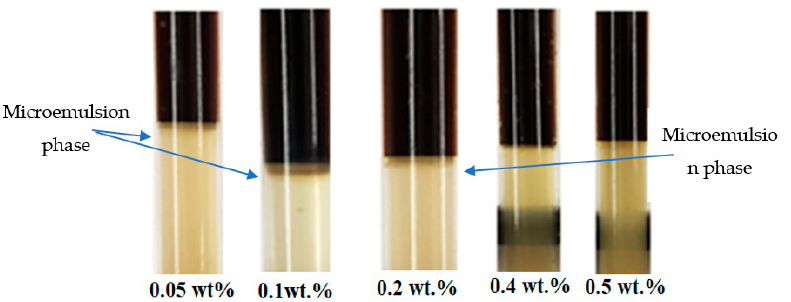
Figure 9. Phase behavior of as-synthesized surfactant with 35 wt.% co-solvent mixture at different concentrations in ratio C (4:1).